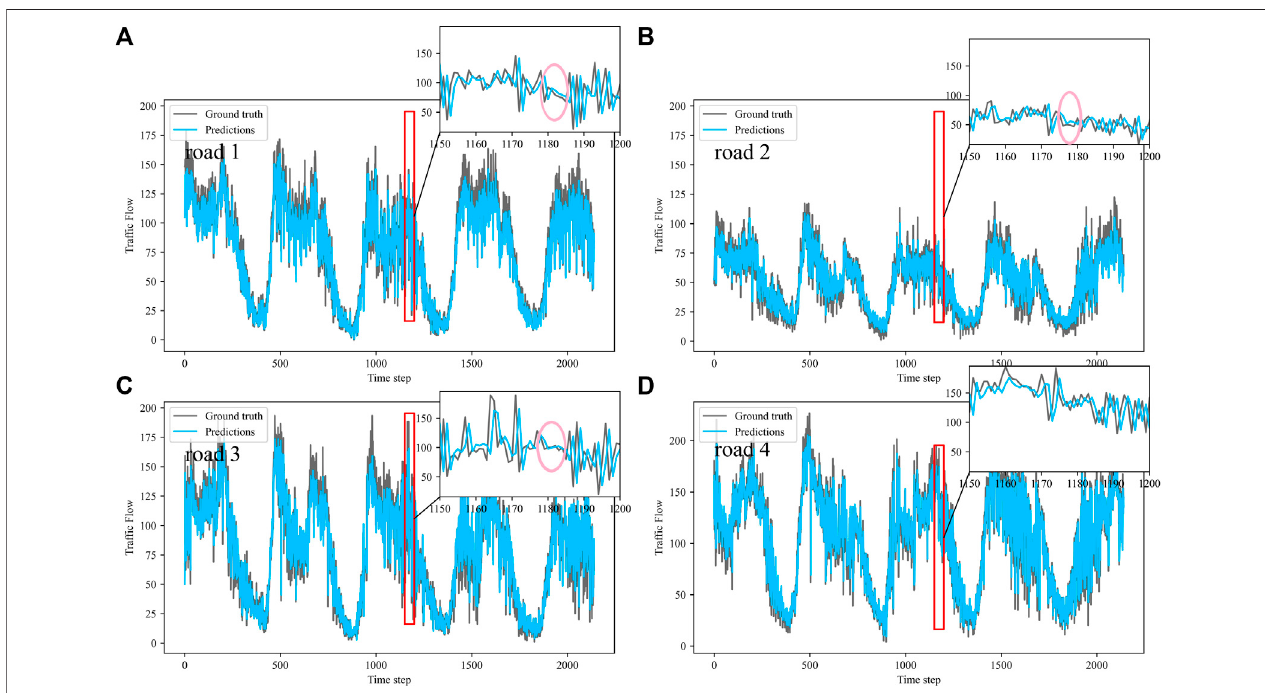
FIGURE 16 | Visualization of IMgruGcn model prediction results on the complete dataset. (A) road 1 means Gudun Road. (B) road 2 means Fengtan Road. (C) road3 means Yile Road. (D) road 4 means Jingzhou